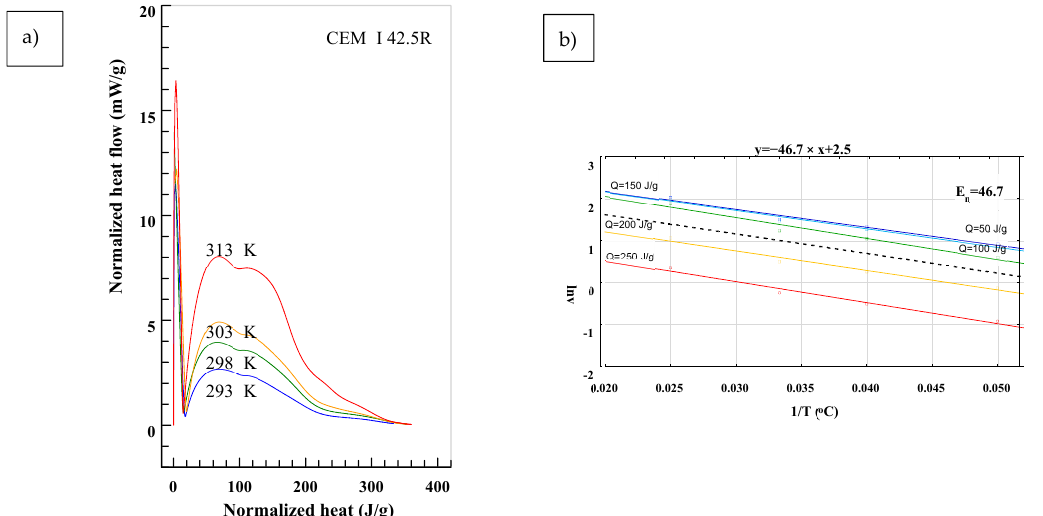
Figure 4. Determination of the En from the Equation (2) for CEM I 42.5 R. ( a ) Normalized heat flow in comparison to total heat generated for different temperatures, ( b ) Values of En for different temperatures and it’s representative value calculated using least-square method.